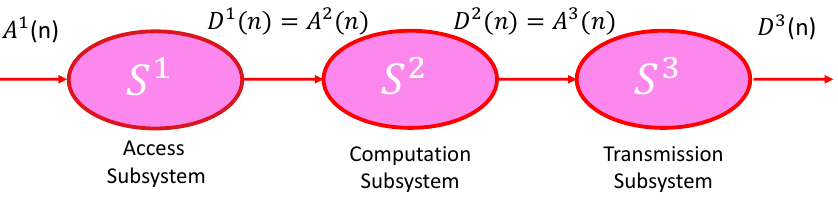
Figure 3. Tandem